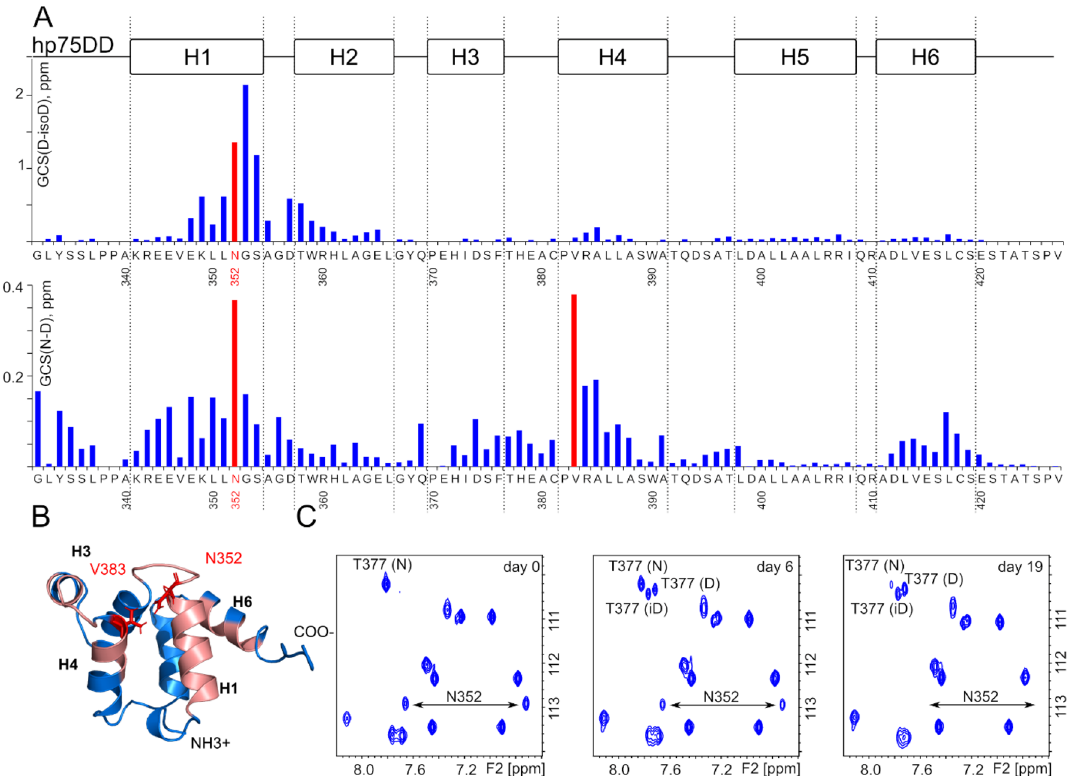
Figure 2. Analysis of the death domain states by NMR. ( A ) Generalized chemical shift changes of cross-peaks in 1 H, 15 N-HSQC spectra between the D352 and isoD352 (on top) and between N352 and D352 (at bottom) states of hP75DD. ( B ) The structure of the death domain (PDB:2N97) is colored with respect to the chemical shift changes upon deamidation. Red are the residues with GCS changes greater than 0.1 ppm. ( C ) A set of three fragments of 1 H, 15 N-HSQC spectra of hP75DD in 50 mM phosphate buffer acquired at immediately, on the 6th day and 19th day after the sample preparation. Positions of Asn352 sidechain NH 2 -group are shown, as well as of three well-resolved signals, corresponding to the different states of Thr377. The figure was prepared using the program Inkscape 0.92 (https ://inksc ape.org/).